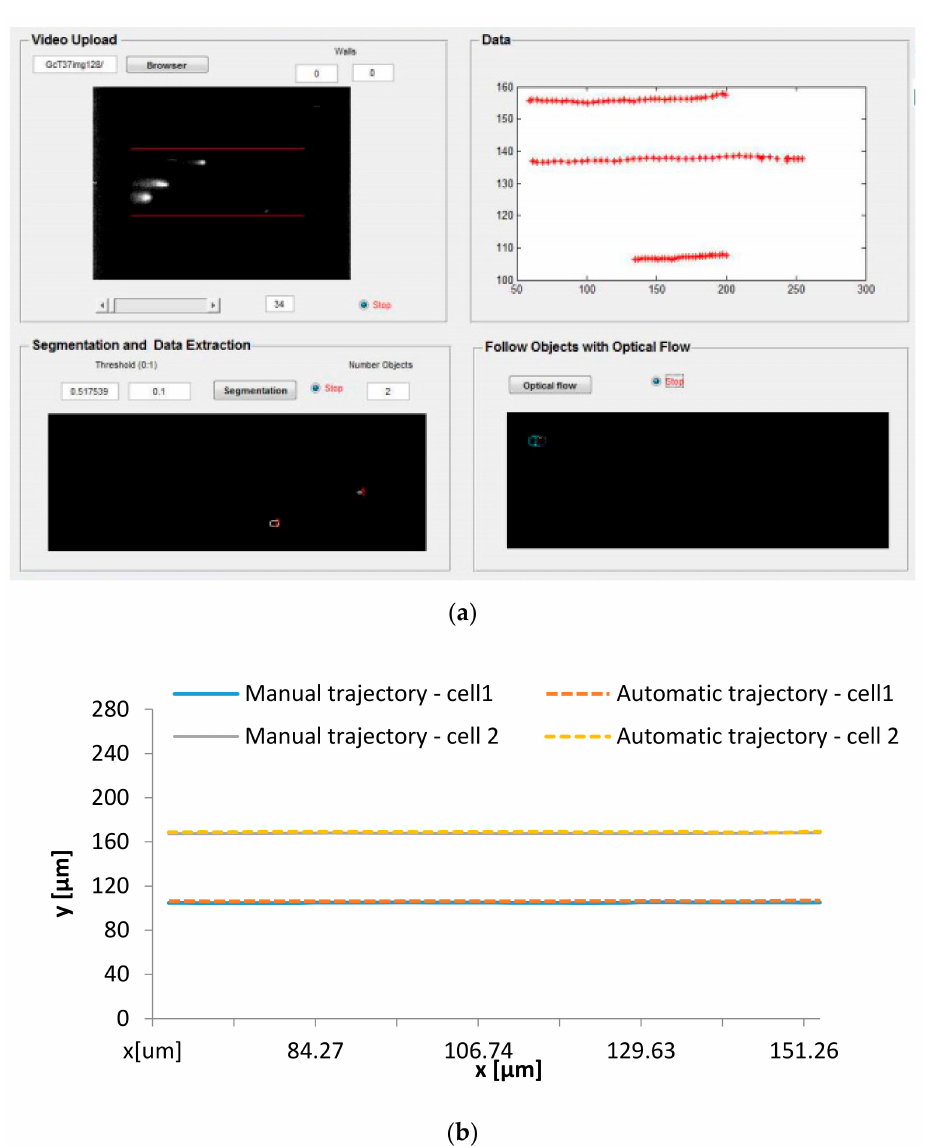
Figure 8. Automatic method results: ( a ) developed graphical user interface (GUI) in MATLAB and ( b ) trajectories of individual labeled RBCs determined by the manual and automatic